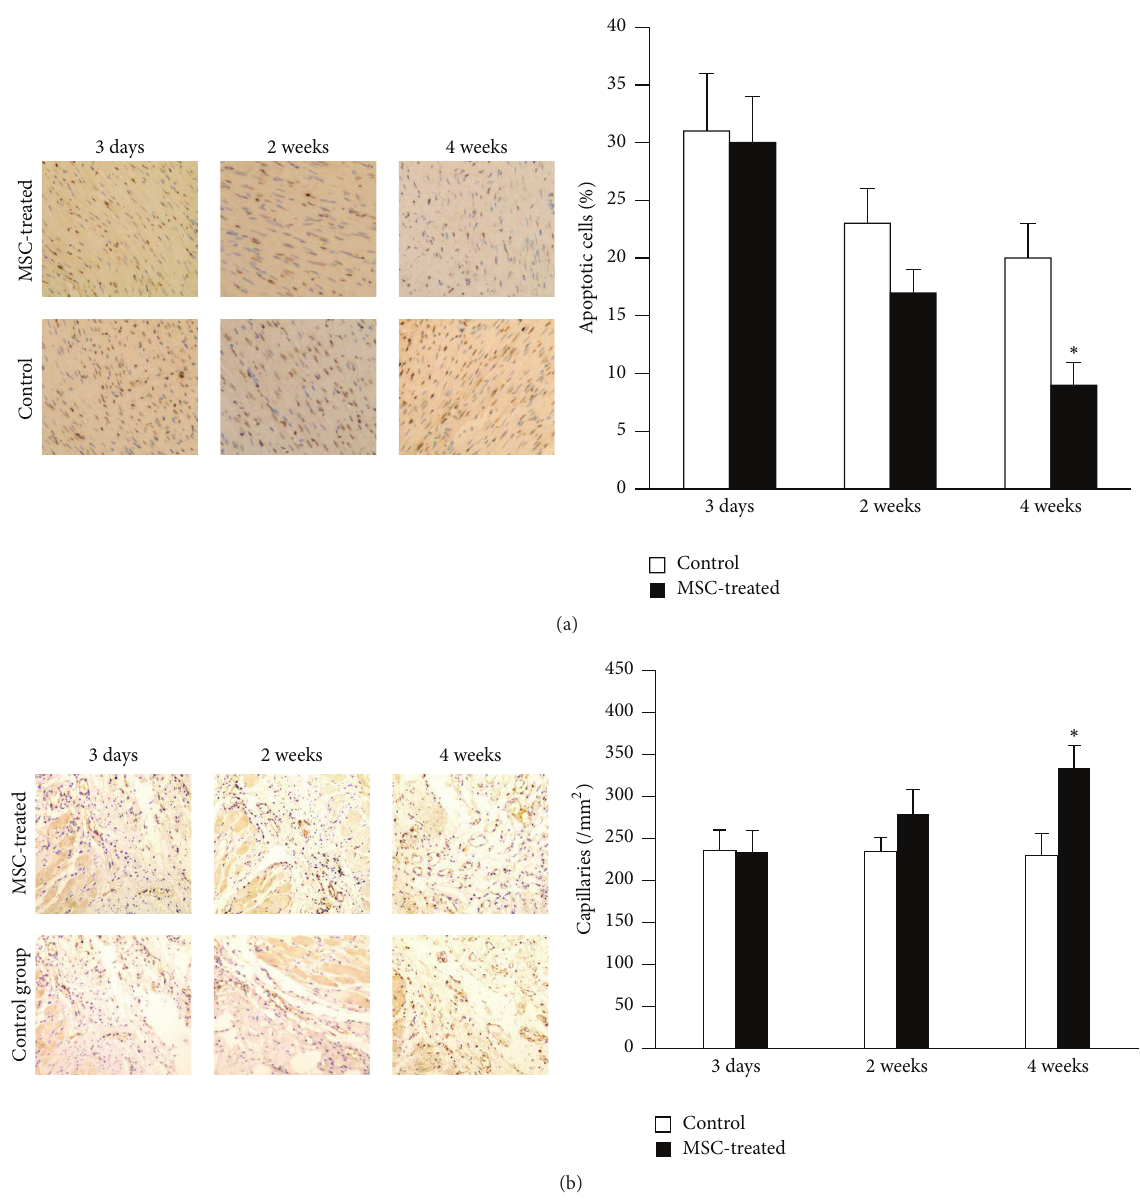
Figure 6: Cardiomyocytes apoptosis and capillary density in peri-infarct area after transplantation. (a) TUNEL staining and apoptosis. (b) CD31 staining and capillary density (original magnification × 200). 𝑁 = 3 for each group and ∗ 𝑝 < 0.05 versus